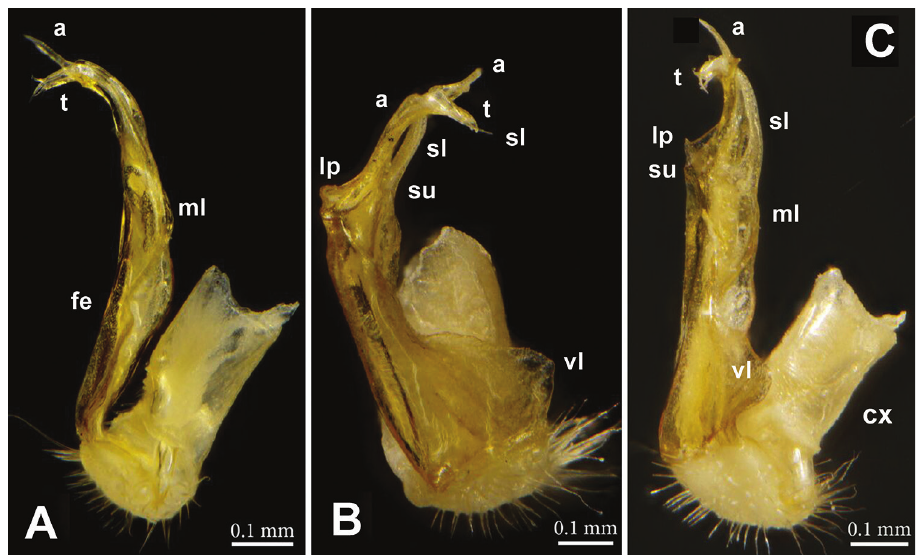
Figure 6. Annamina attemsi sp. n., ♂ paratype (NHMW), right gonopod, A mesal B subventral and C submesal views, respectively (cx = coxite; fe = femorite, vl = ventral lobe; ml = mesal lobe; su = post- femoral sulcus; lp = lateral process; a = apical process; sl = solenomere; t = solenophore